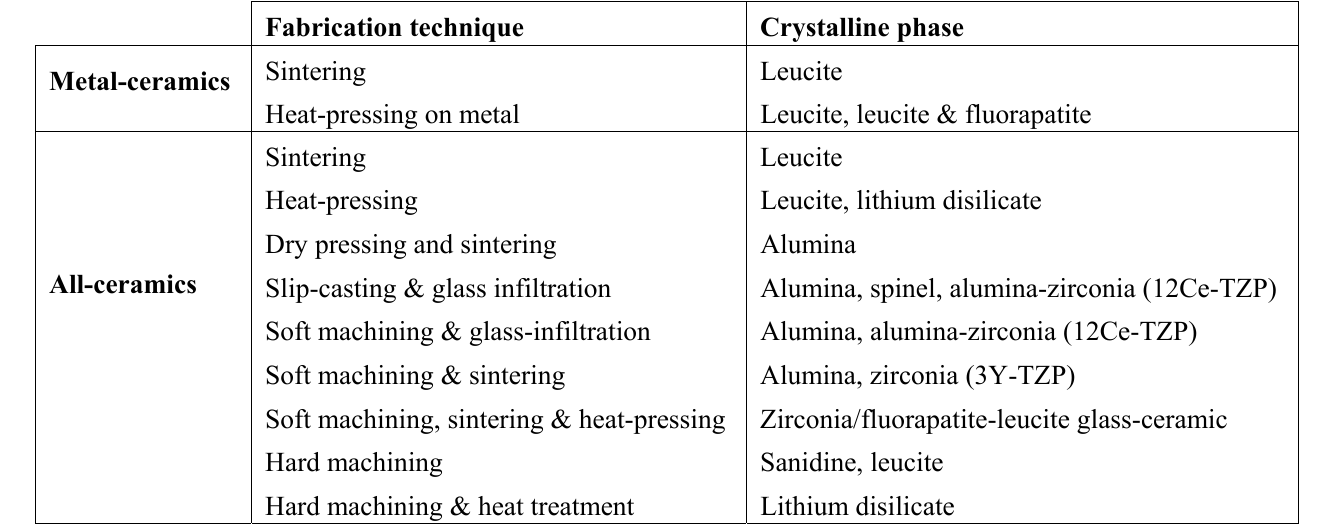
Table 1. Classification of Dental